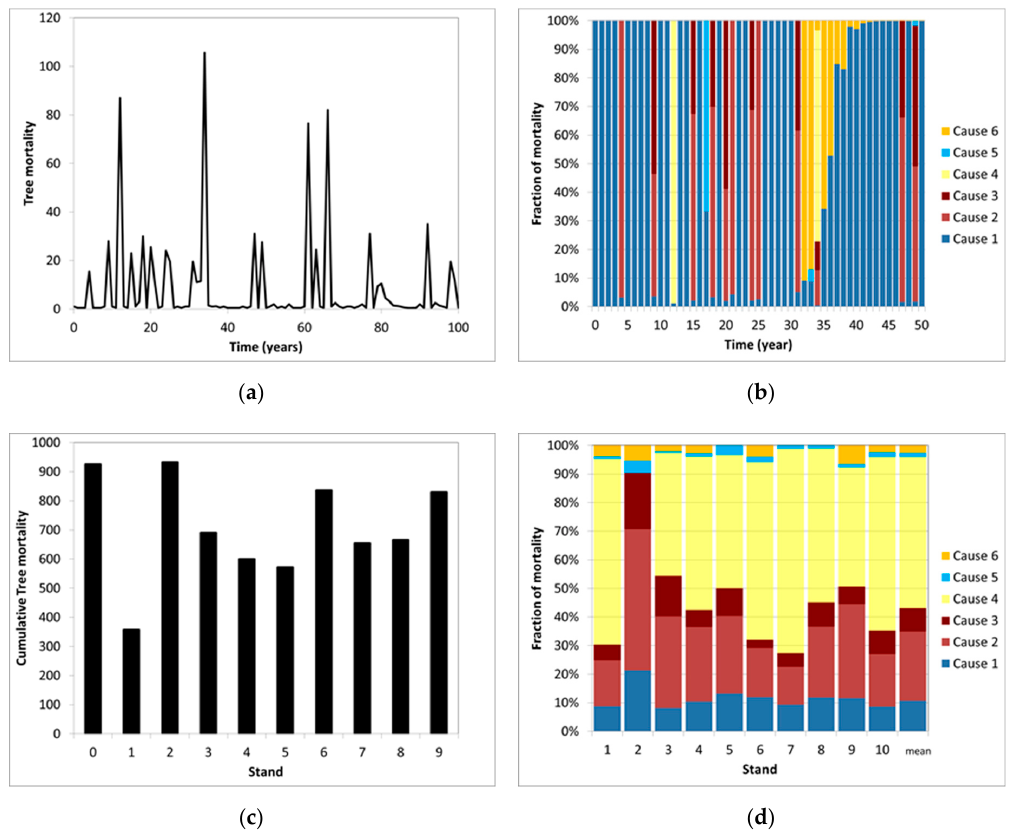
Figure 4. Hypothetical effect of combining various mortality causes that differ in terms of frequency, severity, size profile, and interdependence on total mortality mass input and a cause’s relative contribution. ( a ) Stand-level mortality input for each of 100 years, ( b ) relative contribution of a mortality cause each of the first 50 years, ( c ) cumulative stand-level input over 100 years for 10 stands, and ( d ) relative contribution of causes over a 100-year period for 10 stands. Cause 1 occurred each year but had a low severity (1–2 trees); Cause 2 occurred on average once every 10 years with a moderate severity (10–20 trees); Cause 3 was triggered by Cause 2, but had a 50% chance of following Cause 2; Cause 4 was a moderately frequent, severe disturbance (75–100 trees); Cause 5 was similar to Cause 2 in terms of frequency but killed fewer trees (1–4); Cause 6 was very infrequent (once every 100 years), but once established, lasted 5 years, killing 5–10 trees each year it was active. While our example is restricted to one cause, there is evidence it applies to others. For example, past the wind event, and in some cases, the death might occur so removed from the event that it might not be considered wind-related [45]. Another example is drought-related mortality, which is